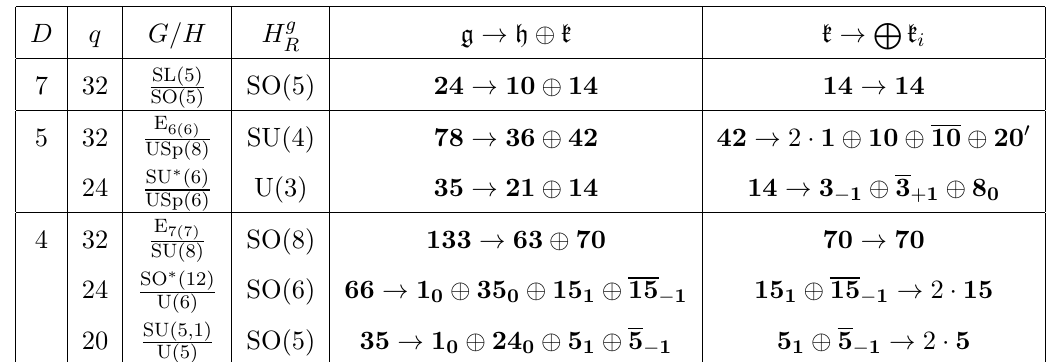
Table 2 . Relevant representation theoretical decompositions for the determination of AdS moduli spaces. Firstly, the branching of the adjoint representation of g into h -representations and secondly the branching of the h -representation corresponding to k into representations of h g